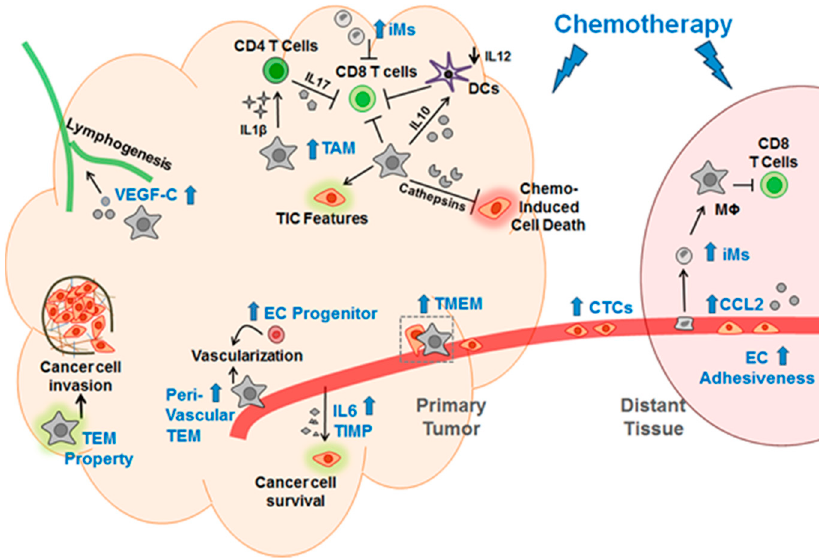
Figure 2. A schematic for the mechanisms by which chemotherapy elicits its pro-cancer effect via modulations of macrophages and endothelial cells. Blue text indicates the changes induced by chemotherapy; blue arrow denotes increase induced by chemotherapy; black arrow indicates promoting the events; black down arrow indicates decrease. M ϕ , macrophage; TEM, Tie2-expressing macrophage; TMEM, tumor microenvironment metastasis; EC, endothelial cells; iM, inflammatory monocyte; DCs, dendritic cells; CTC, circulating cancer cells; TIC, tumor initiation cell; TIMP, tissue inhibitor of metallopeptidase; the green and pink shades denote that the corresponding cells are altered.